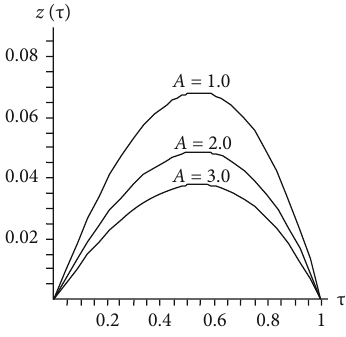
Figure 4: Velocity pro fi le for various values of A with q = 1 : 0 , N = 1 : 0 , R = 1 : 0 , and ji ′ = π /4 .